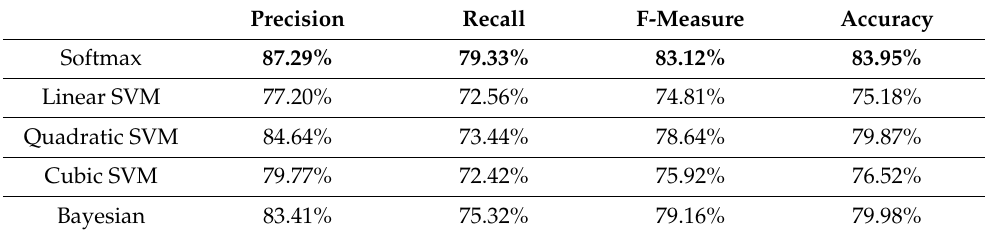
Table 7. Classification performance for original images with dataset augmentation.